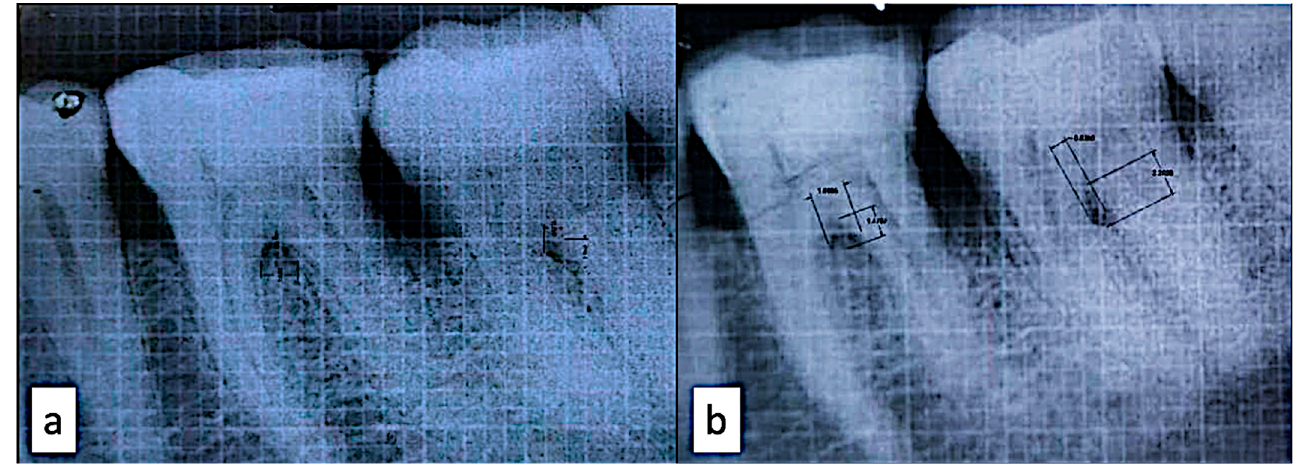
Figure 2. ( a ) IOPAR at baseline; ( b ) IOPAR at 9 months.